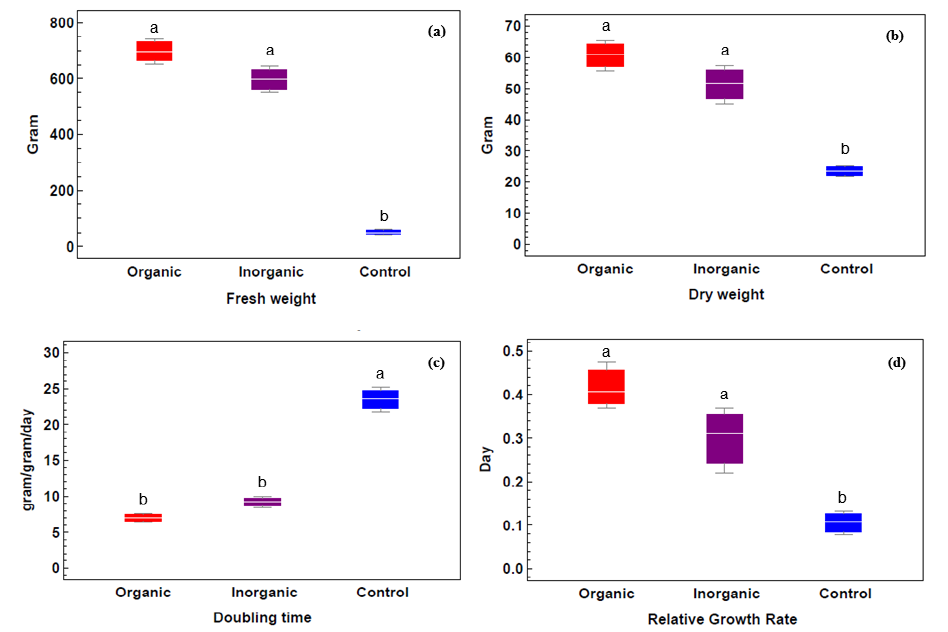
Figure 5. Relative growth rate and doubling time of Azolla sp . samples exposed to di ff erent treatments. ( a ) Fresh weight, ( b ) dry weight, ( c ) doubling time, and ( d ) relative growth rate of Azolla sp . samples under di ff erent treatments (means ± standard errors from three independent experiments under di ff erent treatments: organic, inorganic and control). Di ff erent lowercase letters indicate significant di ff erences between di ff erent treatments at p ≤ 0.05.